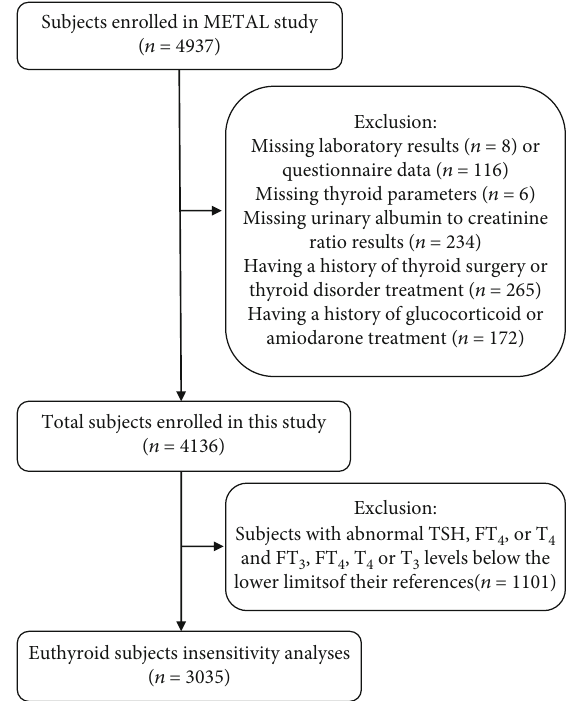
Figure 1: Flowchart of the inclusion and exclusion of